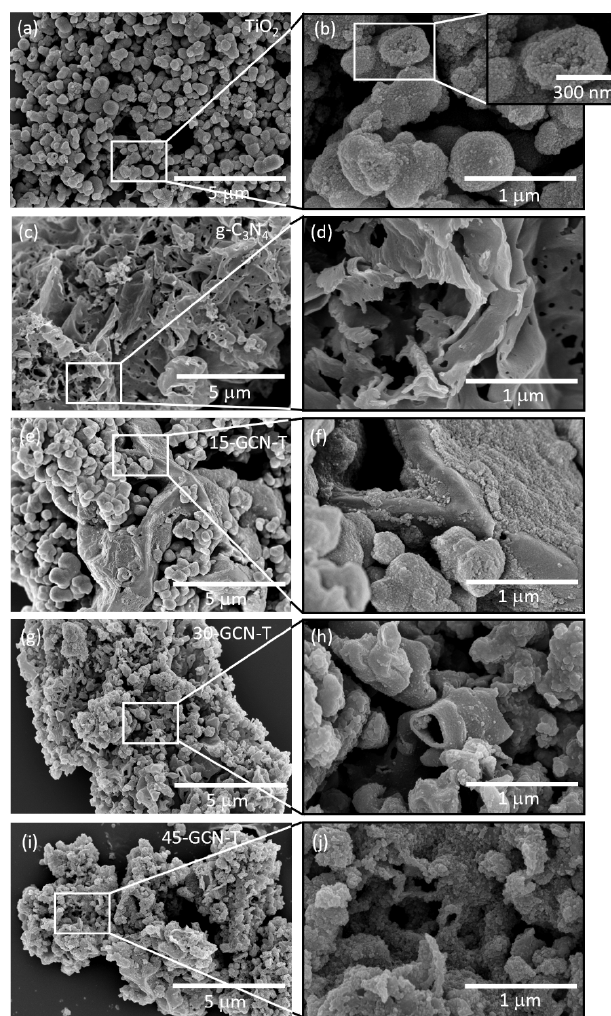
Figure 3 . SEM images of the produced materials ( a ) TiO 2 , ( c ) g-C 3 N 4 , ( e ) 15-GCN-T, ( g ) 30-GCT and ( i ) 45-GCN-T. The respective high-magnification SEM images are shown in ( b , d , f , h , j ). ( b ) also displays an amplified SEM image of a hollow TiO 2 sphere.